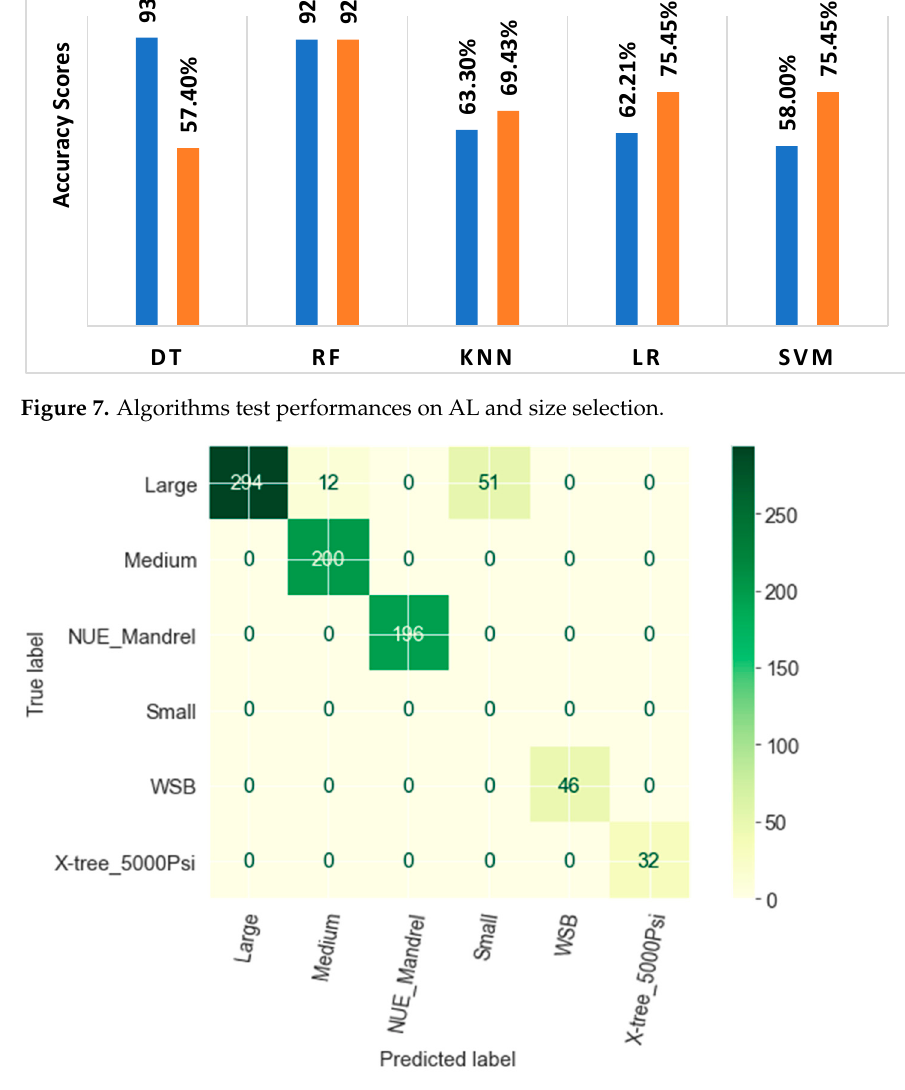
Table 4. AL size selection test accuracies.